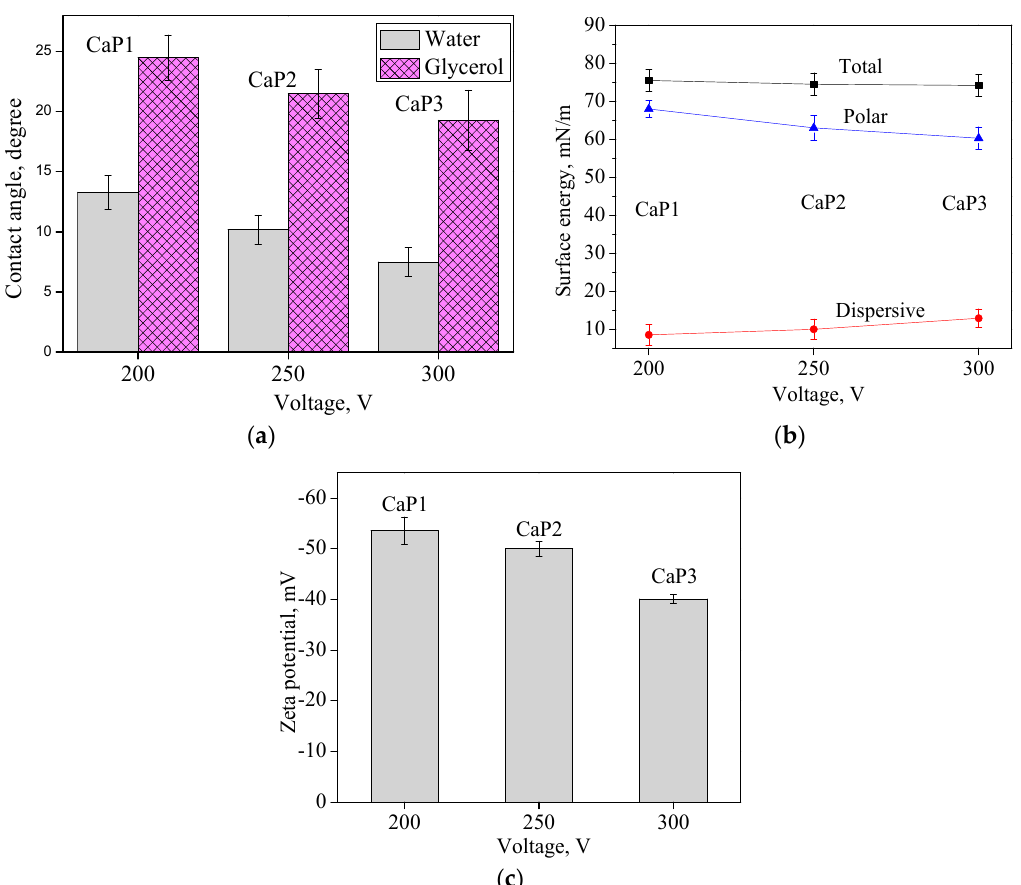
Figure 7. Dependences of contact angles ( a ), surface energy ( b ), and zeta potential ( c ) of CaP coatings on the MAO process voltage.